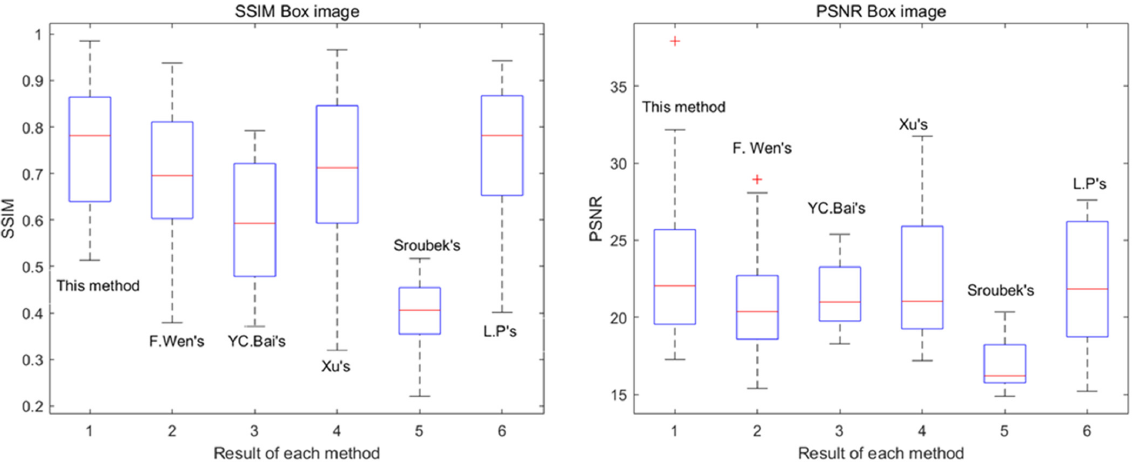
Figure 5. The result; Left is the SSIM; Right is PSNR. The red line is the average. The blue box is the main area of concentration for the median 50% of the data. The black horizontal line indicates the highest value in the median region. The red cross indicates the highest value for the entire set. If there is no red cross, then the highest value is at the black horizontal line